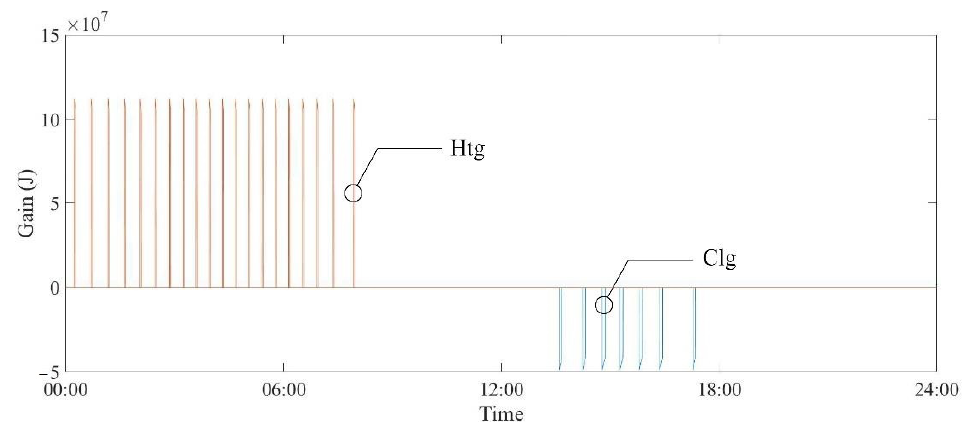
Figure 9. Energy consumption controlled by SC.